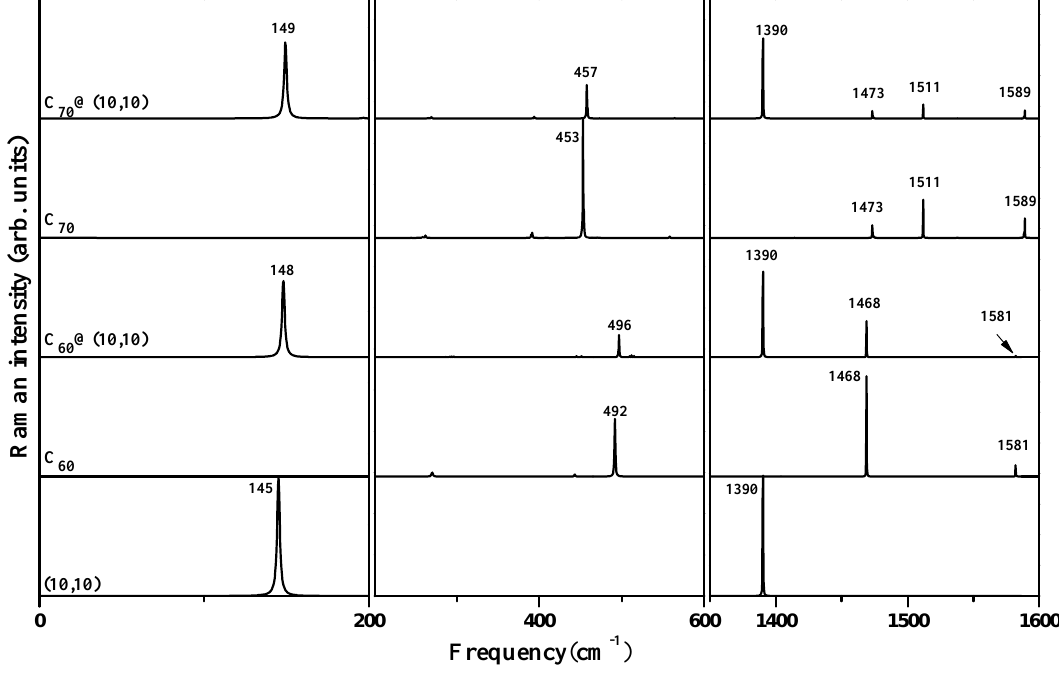
Figure 2. Calculated ZZ-polarized Raman spectra of infinite C 60 @(10,10) and C 70 @(10,10) peapods. Spectra of infinite empty (10,10) SWBNNT, C 60 and C 70 molecules are also reported for